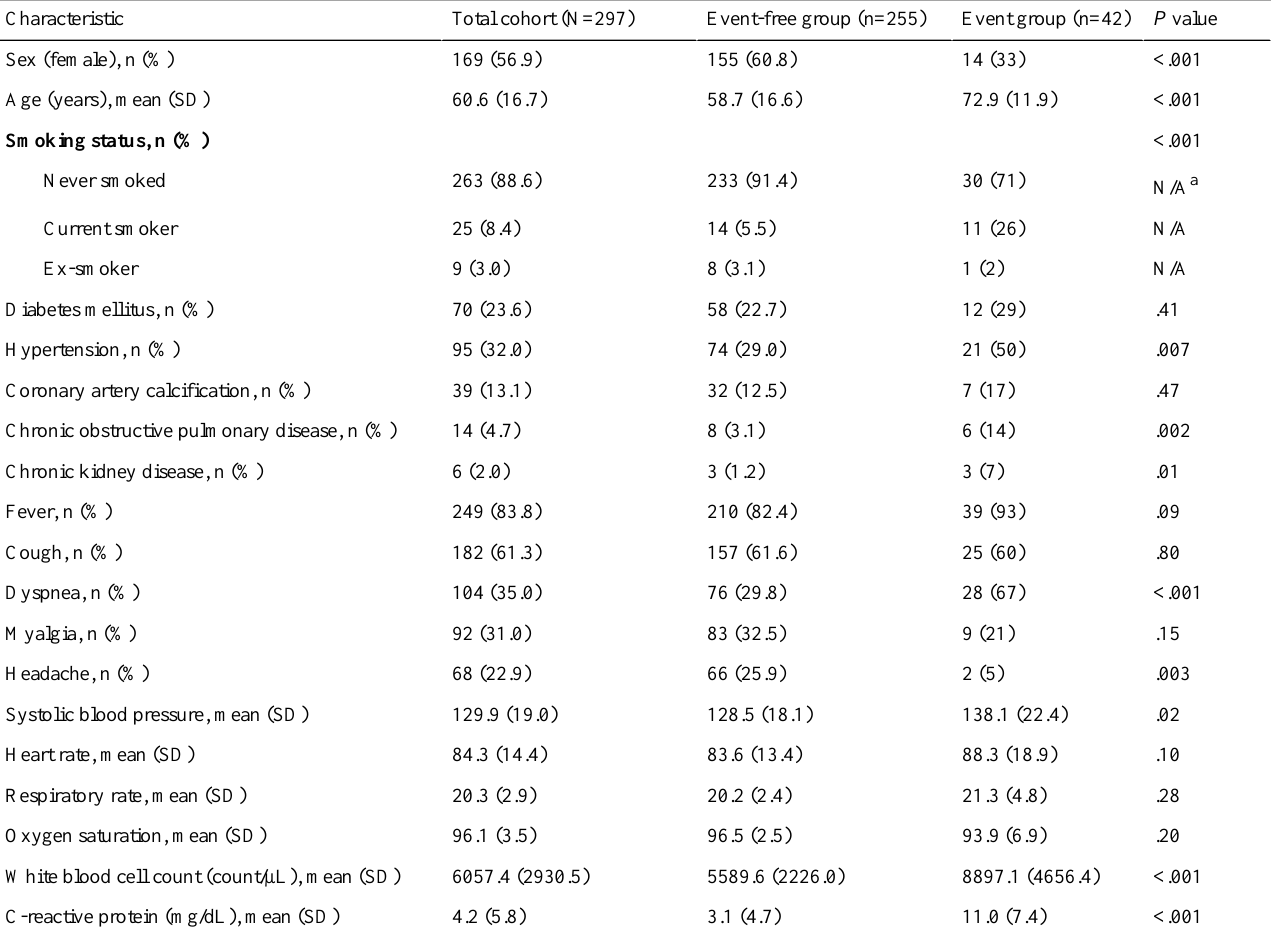
Table 1. Demographic and clinical data for the event versus event-free data